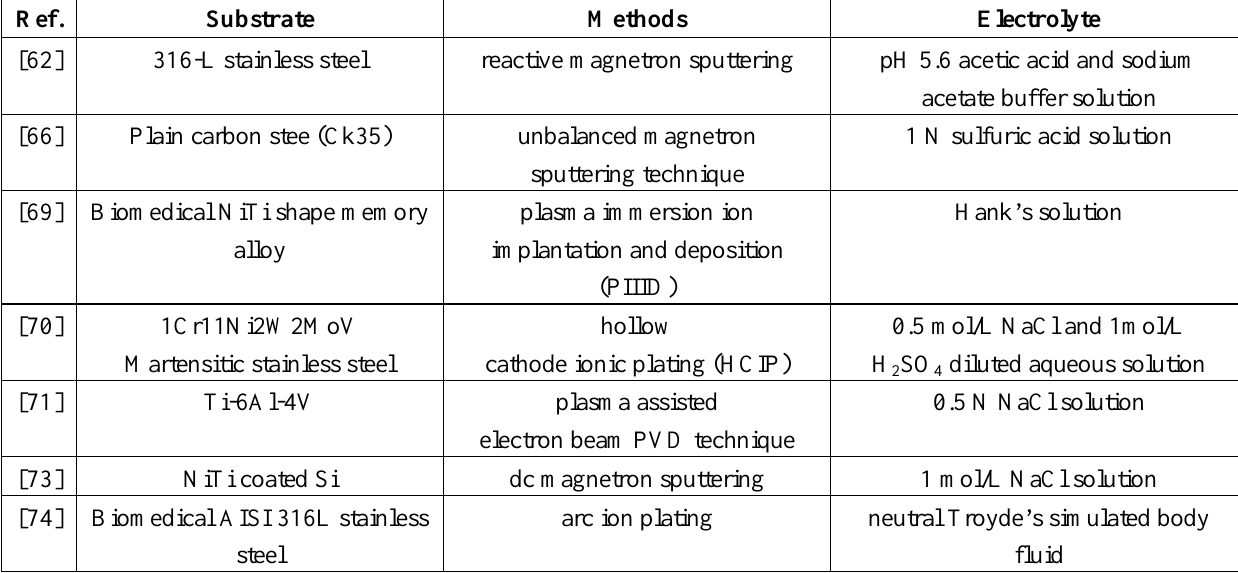
Table 2. Summary of anti-corrosion TiN